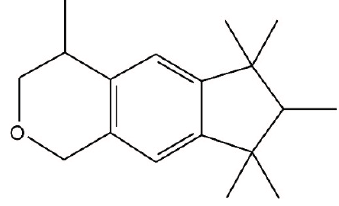
Figure 1. Galaxolide (HHCB) chemical